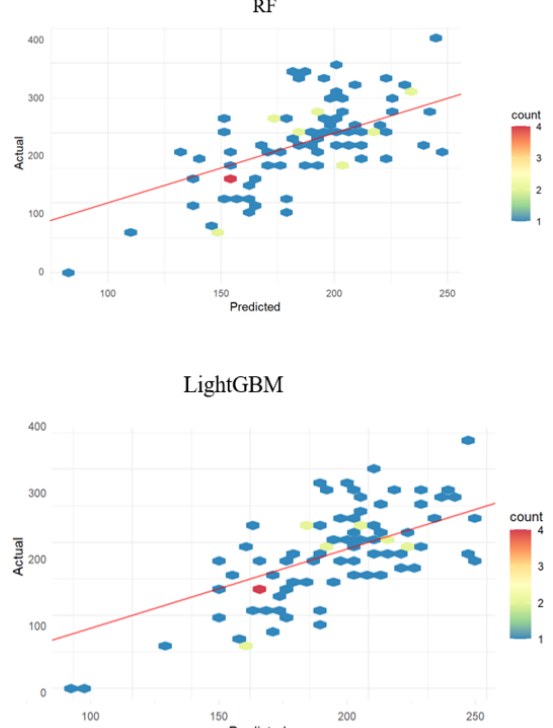
Figure 3 . Scatter plots of actual versus predicted AGB for the combination of airborne LiDAR, Landsat 5, and ALOS PALSAR data using RF and LightGBM